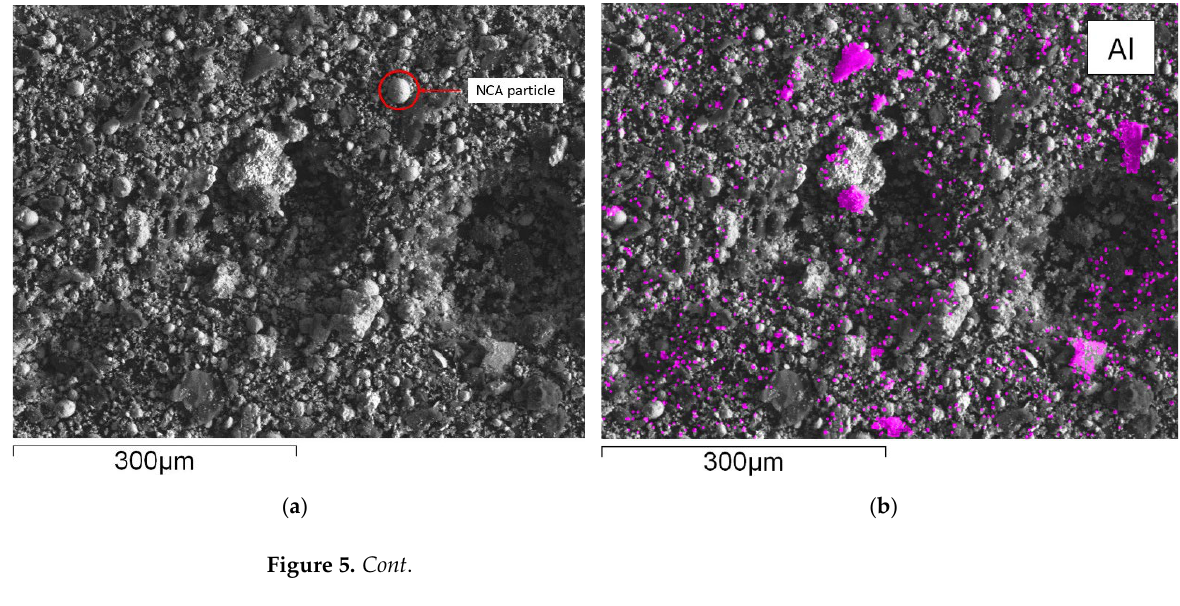
Table 5. ICP-OES analysis of relevant elements in the sample after flotation for use in downstream InduMelt experiment in wt.-%.